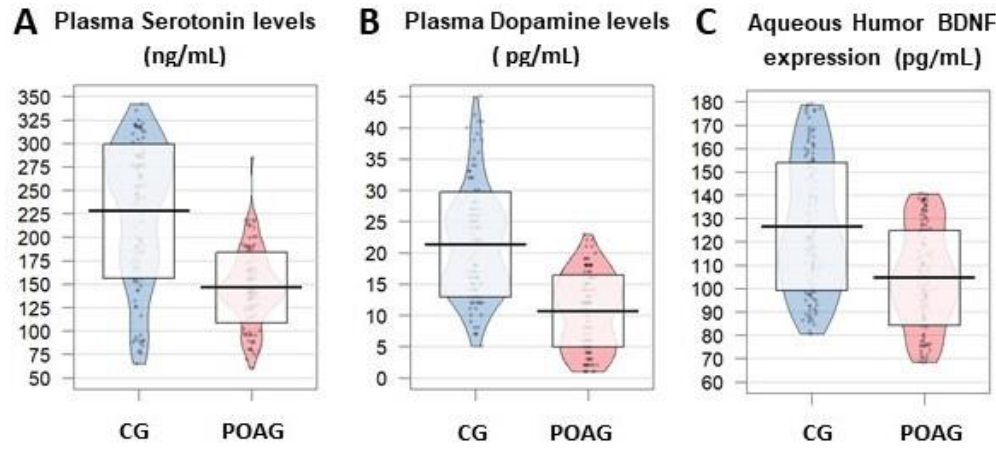
Figure 6. Neuroprotectants and neurotransmitters in the study participants. ( A , B ) Plasma serotonin and dopamine expression (ng / mL) was significantly lower in samples of the POAG patients than in the CG. ( C ) Brain Derived Neurotrophic Factor (BDNF) aqueous humor expression (pg / mL) was significantly lower in the POAG vs. the CG. CG: control group (cataract subjects as comparative group); POAG: primary open-angle glaucoma; BDNF: brain-derived neurotrophic factor. p < 0.05 for all parameters .